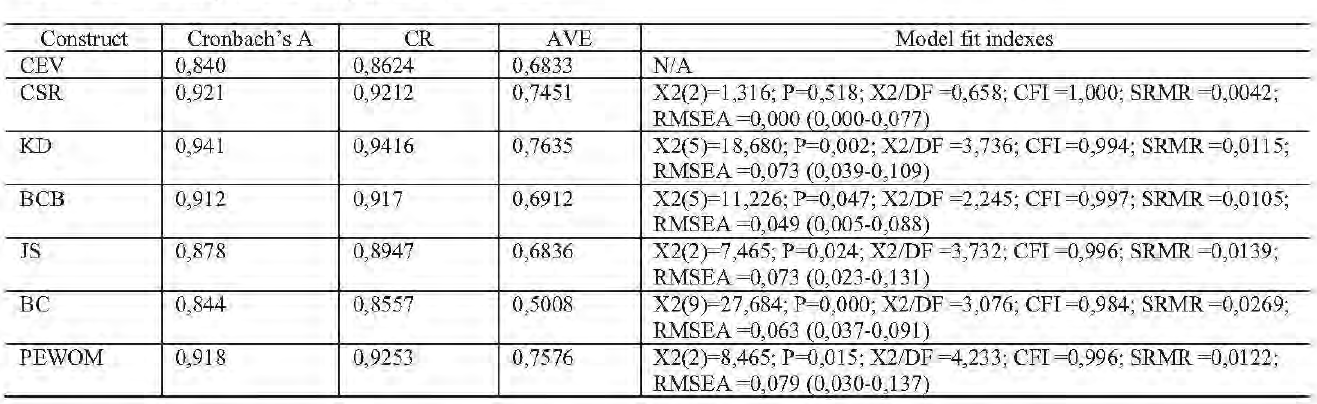
Table 1: Reliability and validity tests of each scale